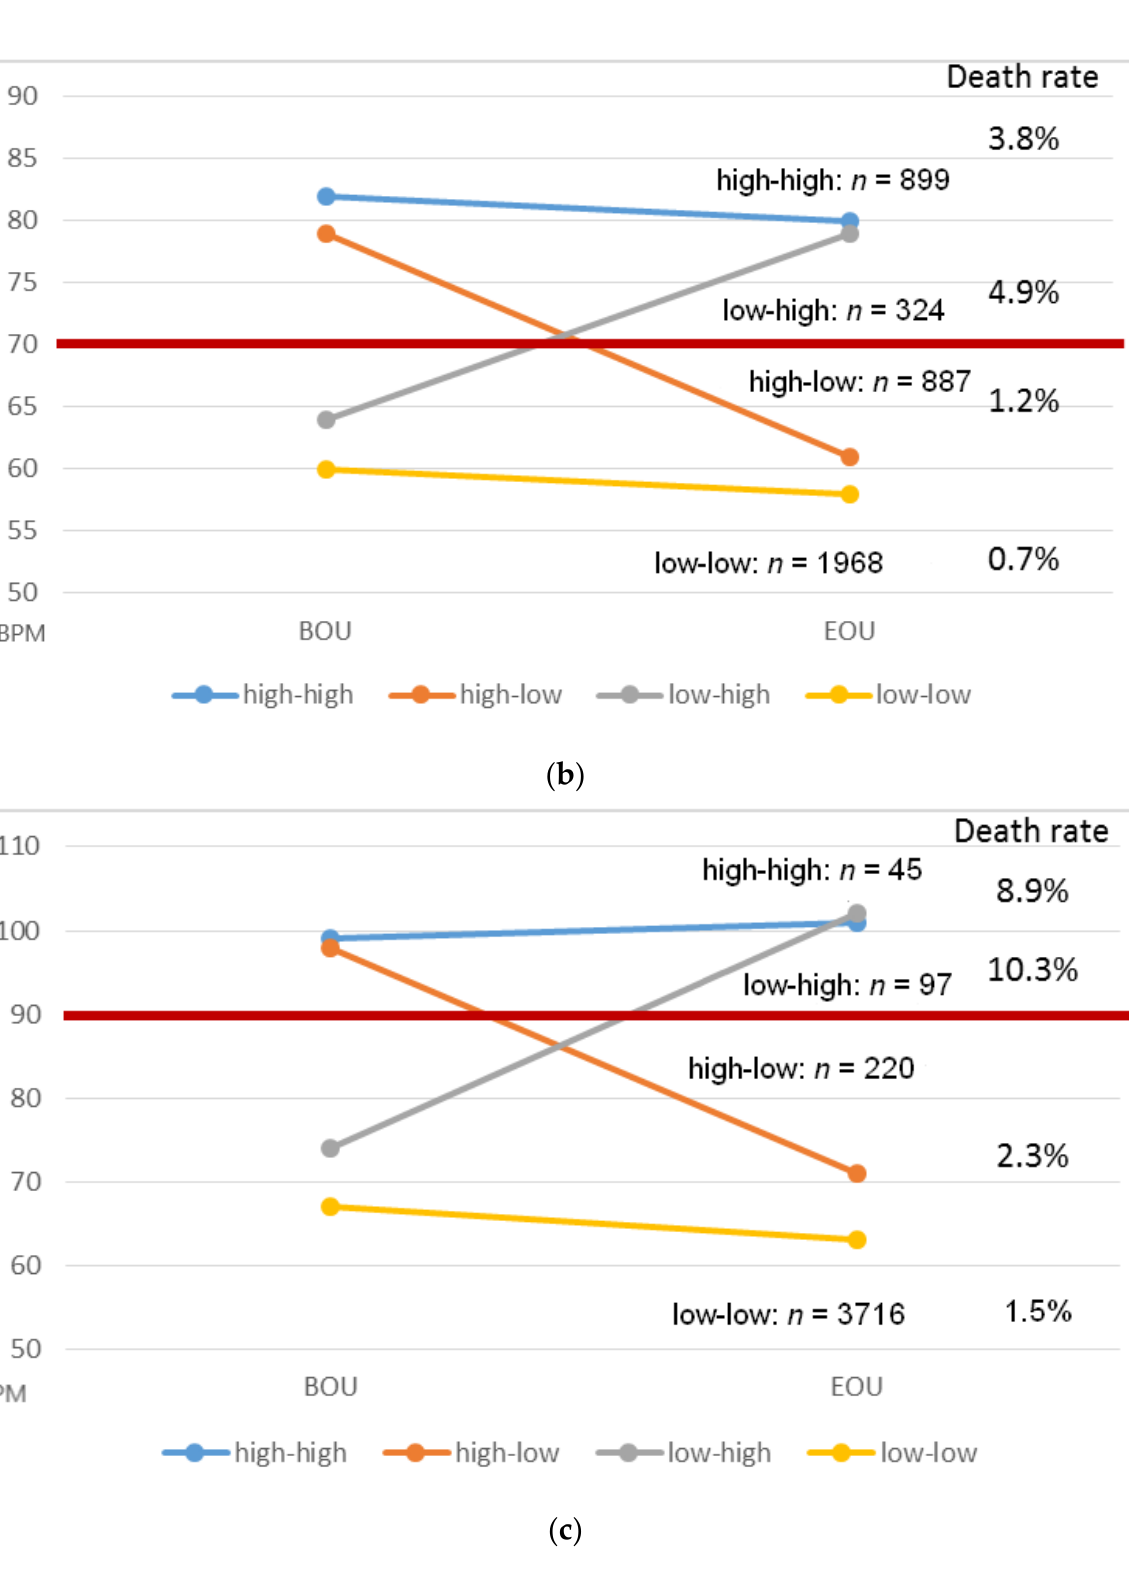
Figure 3. ( a ) The percentage of patient HR > 70 and HR > 90 at EOU. ( b ) Death rates as a function of nighttime HRs with a threshold of 70 bpm at BOU and EOU. ( c ) Death rates as a function of nighttime HRs with a threshold of 90 bpm at BOU and EOU.